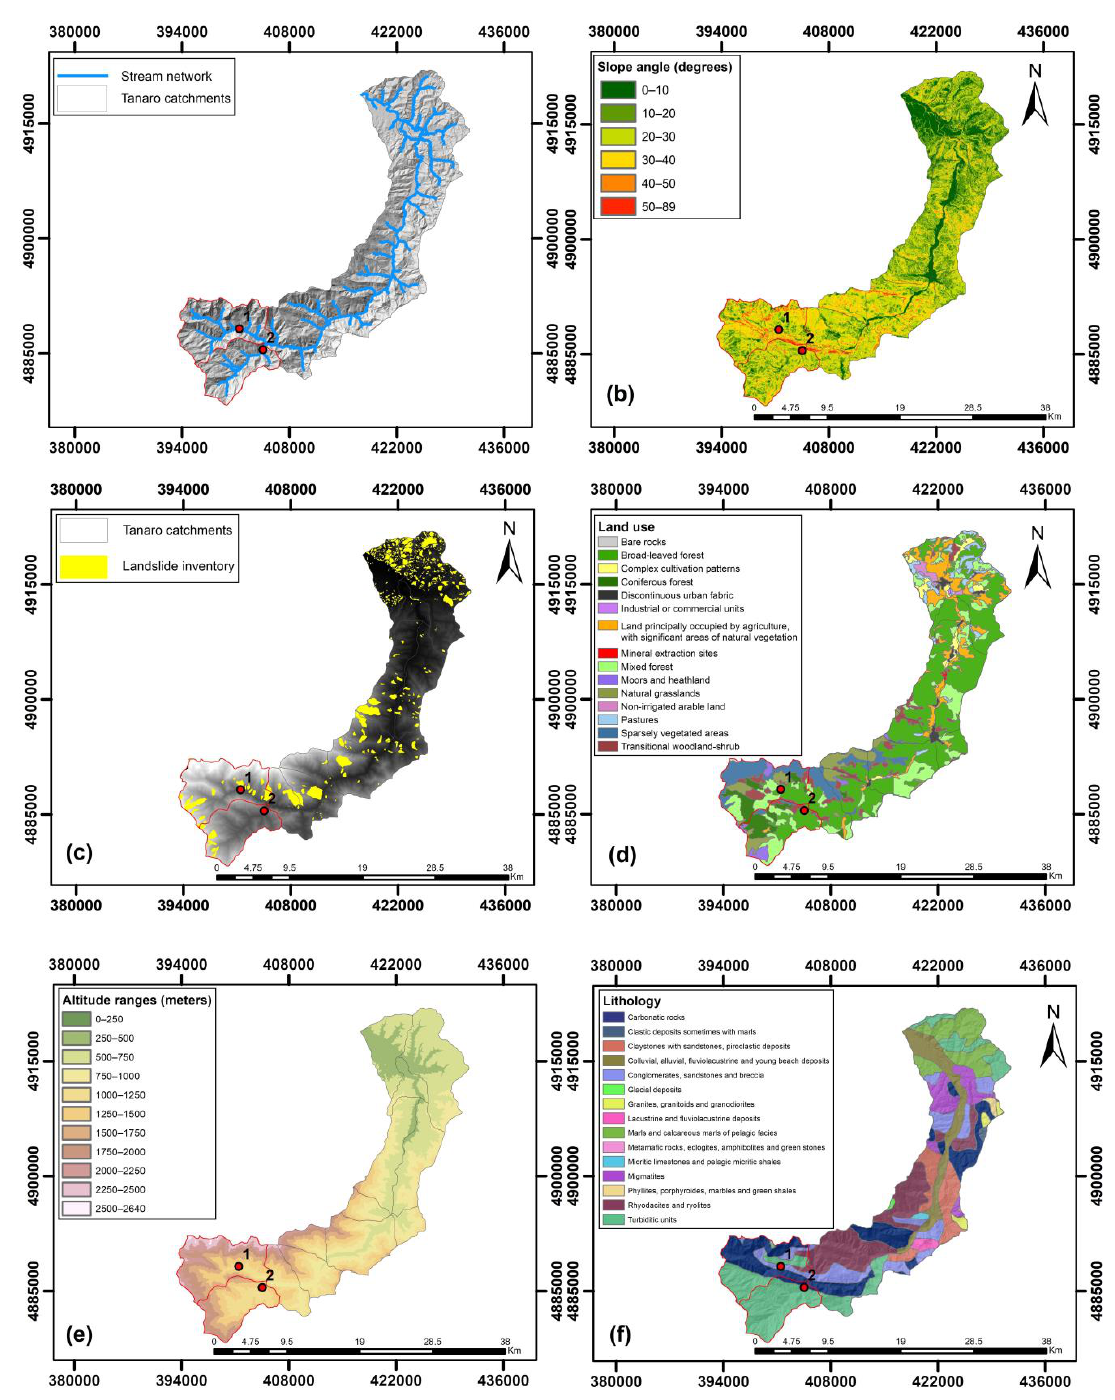
Figure 3. ( a ) Drainage network of the UTV, provided by [16,17]; ( b ) Slope; ( c ) 5 m resolution DTM of Liguria and Piemonte regions [18 – 20] and landslide distribution modified from [21]; ( d ) Land use map of Liguria Region and Piemonte Region [22,23]; ( e ) Elevation classification; ( f ) Lithological map modified from [24]. In red, the two largest secondary basins of the UTV are shown (Negrone River to the N and Tanarello River to the S), while the red dots indicate the position of the identified sites and their id number: 1 for the site on the Negrone River and 2 for the site on the Tanarello River.